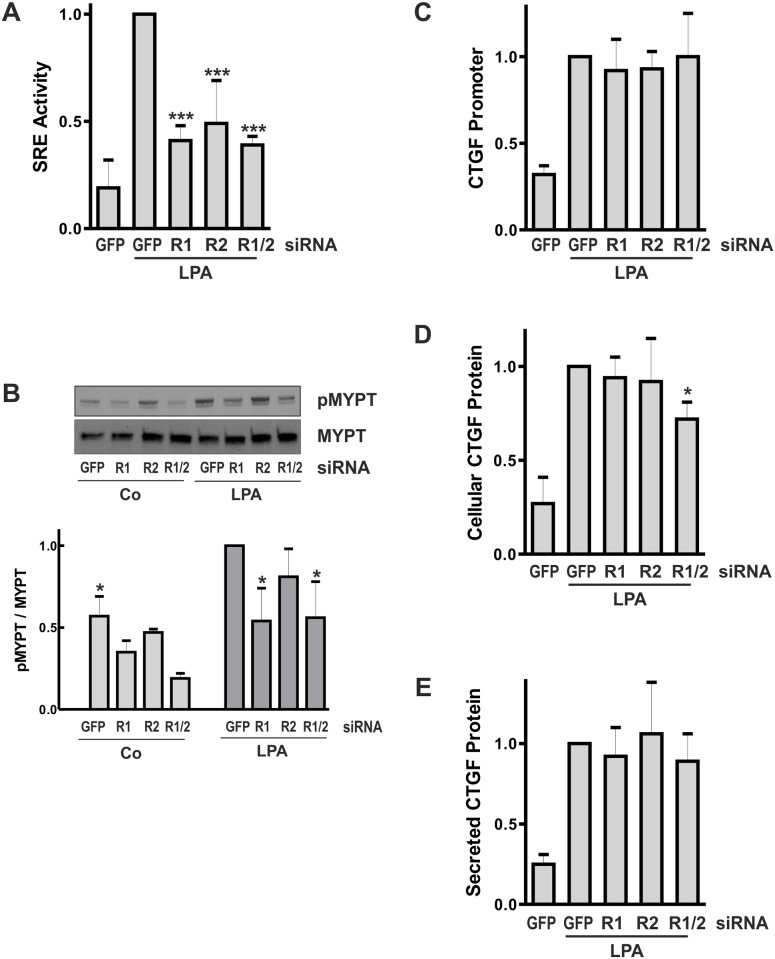
Transient down-regulation of Rho kinases is not sufficient to impair CTGF expression.HKC-8 cells were treated with siRNA directed against GFP, ROCK1 (R1) or ROCK2 (R2), or a combination of both (R1/2) 3 h after seeding. (A) One day after siRNA transfection, HKC-8 cells were transfected with SRE constructs. Relative luciferase activity was determined in control cells and cells stimulated with LPA for 4 h. The graph summarizes means ± SD of 3 to 5 independent experiments. SRE activity in cells stimulated with LPA was set to 1 in each experiment. Statistics were calculated for LPA-stimulated samples. *** p< 0.001, ANOVA with Tukey’s multiple comparison. (B) Phosphorylated MYPT (pMYPT) was detected by Western blot analysis in control cells and in cells stimulated with LPA for 3–5 min 48 h after siRNA treatment. Detection of total MYPT was used as control. The graph summarizes data of 3 experiments (mean ± SD). Expression of pMYPT/MYPT in LPA-stimulated siGFP-transfected cells was set to 1 in each experiment; * p<0.05 compared to LPA-stimulated siGFP-transfected cells. (C) One day after siRNA transfection, HKC-8 cells were transfected with CTGF promoter constructs. Stimulation with LPA was 4 h. The graph summarizes means ± SD of 3–4 independent experiments. Promoter activity in LPA-stimulated siGFP-transfected cells was set to 1 in each experiment. (D) CTGF protein was detected in cellular homogenates. Data are means ± SD of 3–5 independent experiments. CTGF protein detected in LPA-stimulated cells was set to one in each experiment. * p<0.05 compared to LPA-stimulated siGFP-transfected cells. (E) CTGF protein was detected in cell culture supernatants. Data are means ± SD of 3–4 independent experiments.